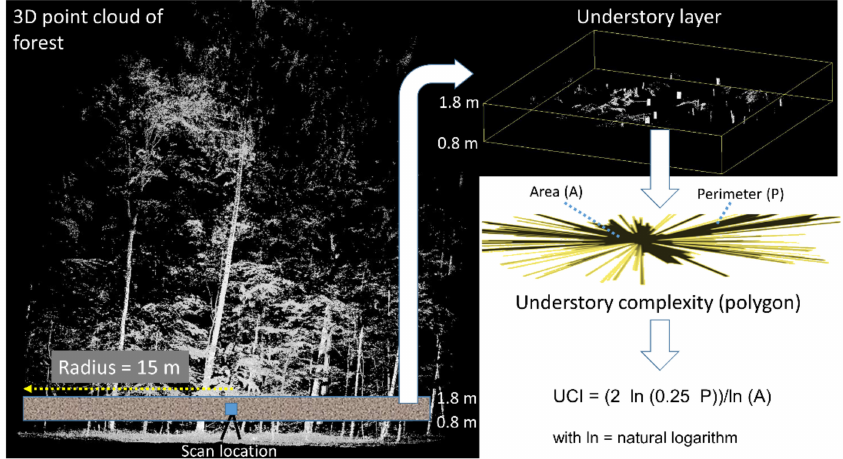
Figure 4. Graphical visualization of the calculation of the understory complexity index (UCI) based on a polygon connecting all hits in a horizontal layer of 1-m thickness centered at breast height (1.3